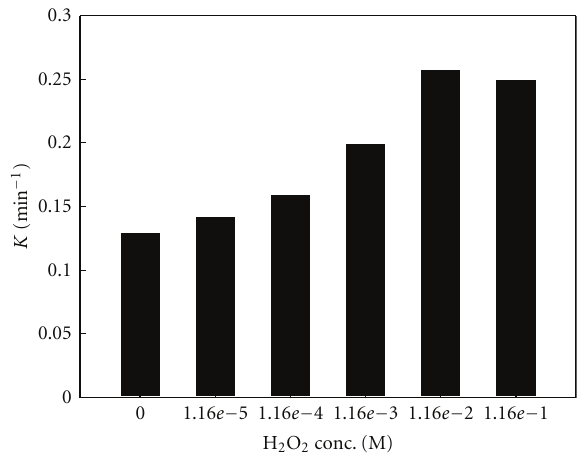
Figure 6: E ff ect of injection H 2 O 2 for decomposition of RB in aqueous solutions.